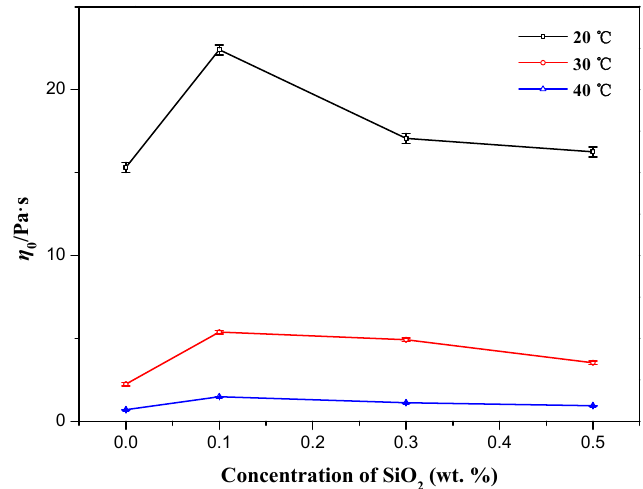
Figure 2. Zero-shear viscosity ( η 0 ) of NEWMS with different nanoparticle concentrations at 20, 30, and 40 °C.